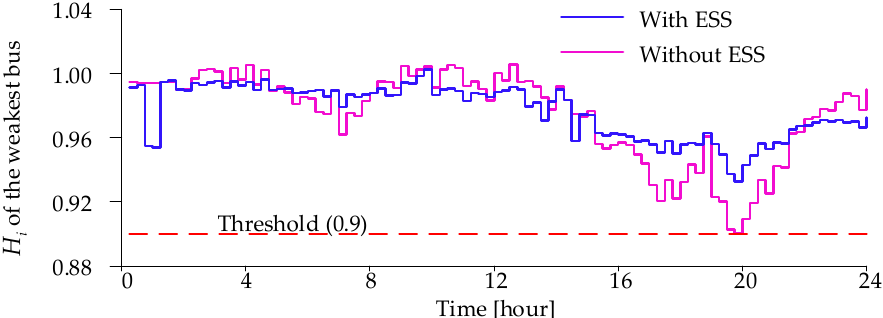
Figure 14. Comparison of